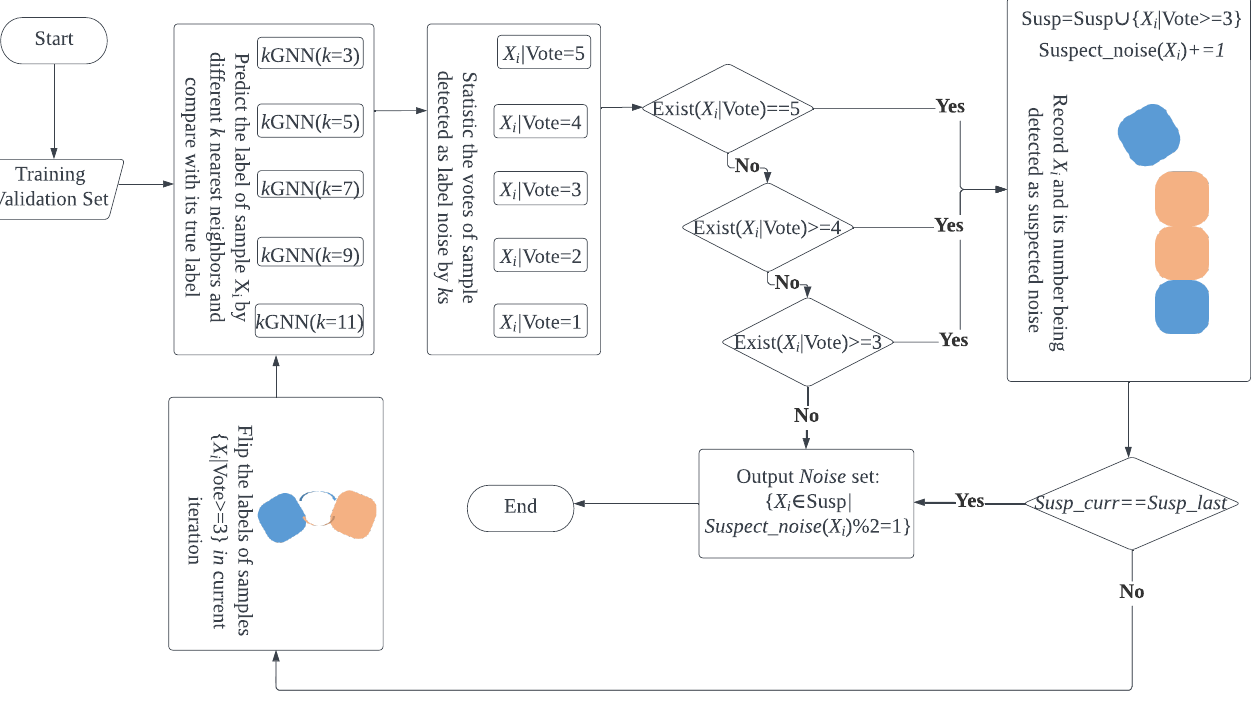
Figure 2. The inner loop of EIRS- k GNN to detect label noise.